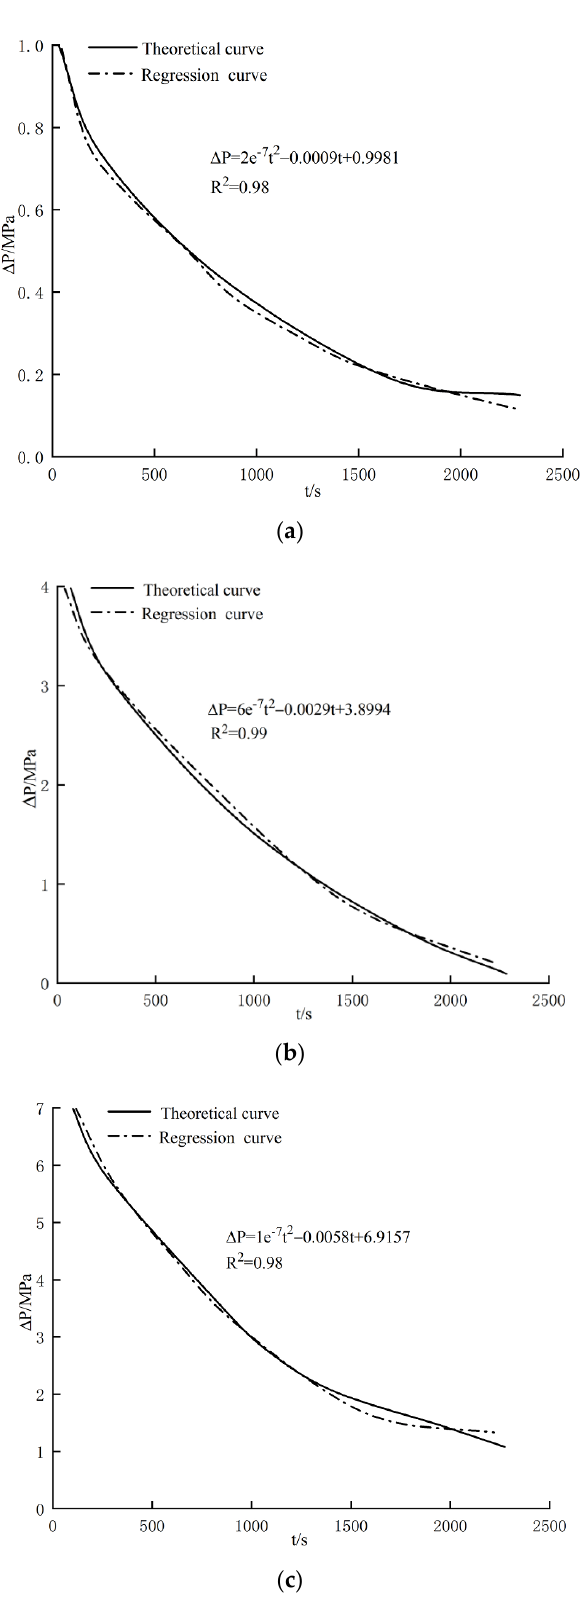
Figure 12. Relationship between pore water pressure and time during non-Darcy seepage in sandstone. ( a ) Pore pressure 1 MPa; ( b ) pore pressure 4 MPa; ( c ) pore pressure 7 MPa.